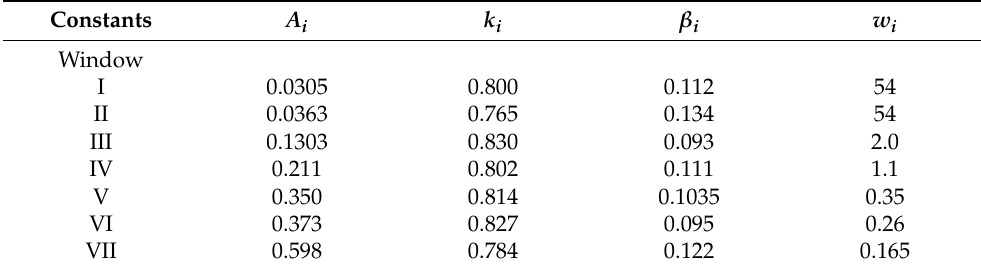
Table 12. Constant values used in Equations (58) and (59) adapted from [28]. Constants A i k i β i w